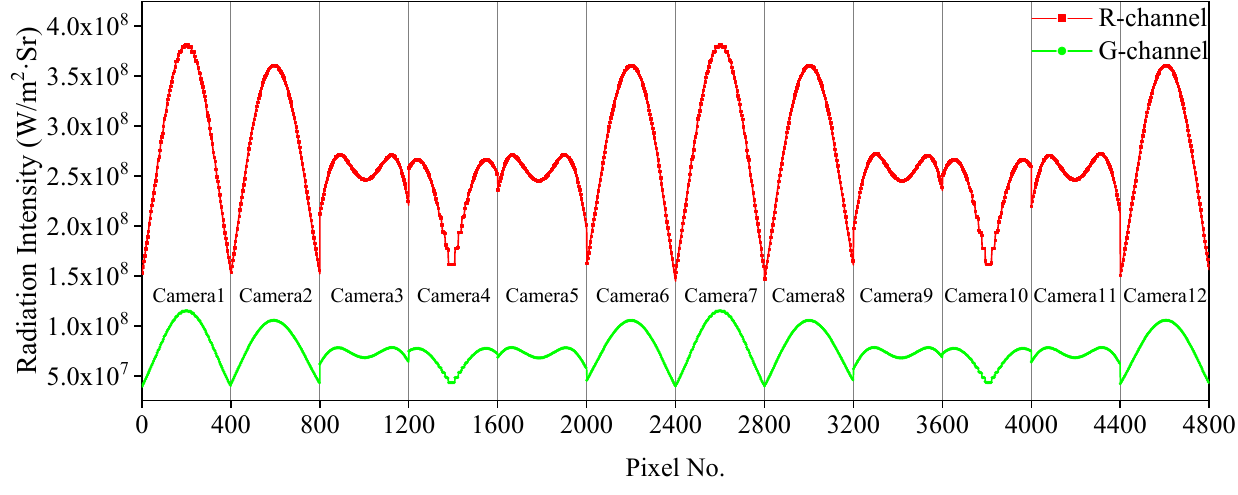
Figure 5. Theoretical radiation intensity of the R and G channels collected by 12 CCD cameras with 400 pixels per camera (up to 4800 pixels).